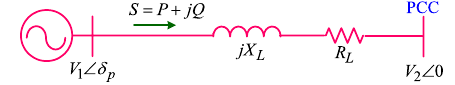
Fig. 3 Equivalent model of standalone inverter connected to the